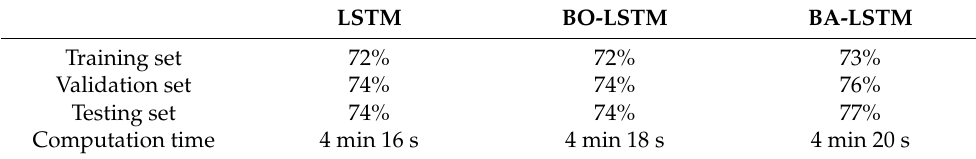
Table 12. The prediction accuracy and time for RUL (engine